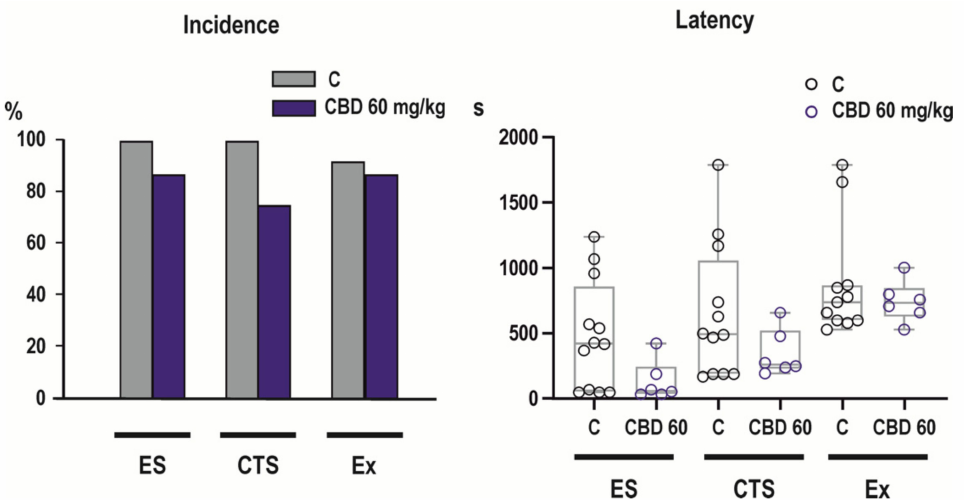
Figure 3. Effects of CBD in NMDA model. Pre-treatment with 60 mg/kg CBD did not affect incidence (left panel) of any evaluated parameters of NMDA-induced seizures—emprostotonic (flexion) seizures (ES), generalized clonic tonic seizures (CTS) or mortality (Ex). Latencies (right panel) of individual parameters did not differ from controls. Other details as in Figure 2.